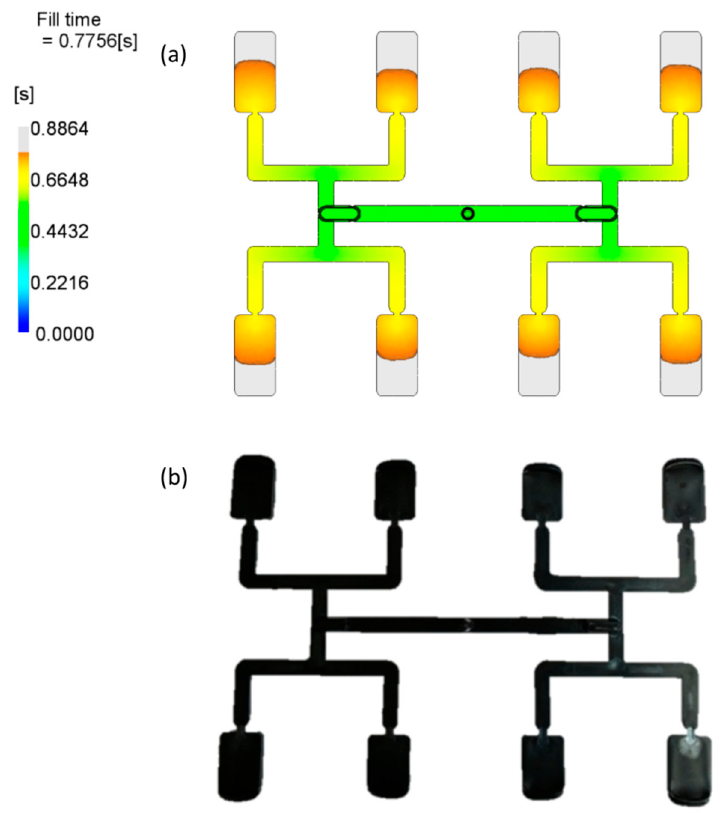
Figure 12. Results of simulation and experimentation for the optimum set of data (by STASA QC): ( a ) simulation, ( b ) experiment.